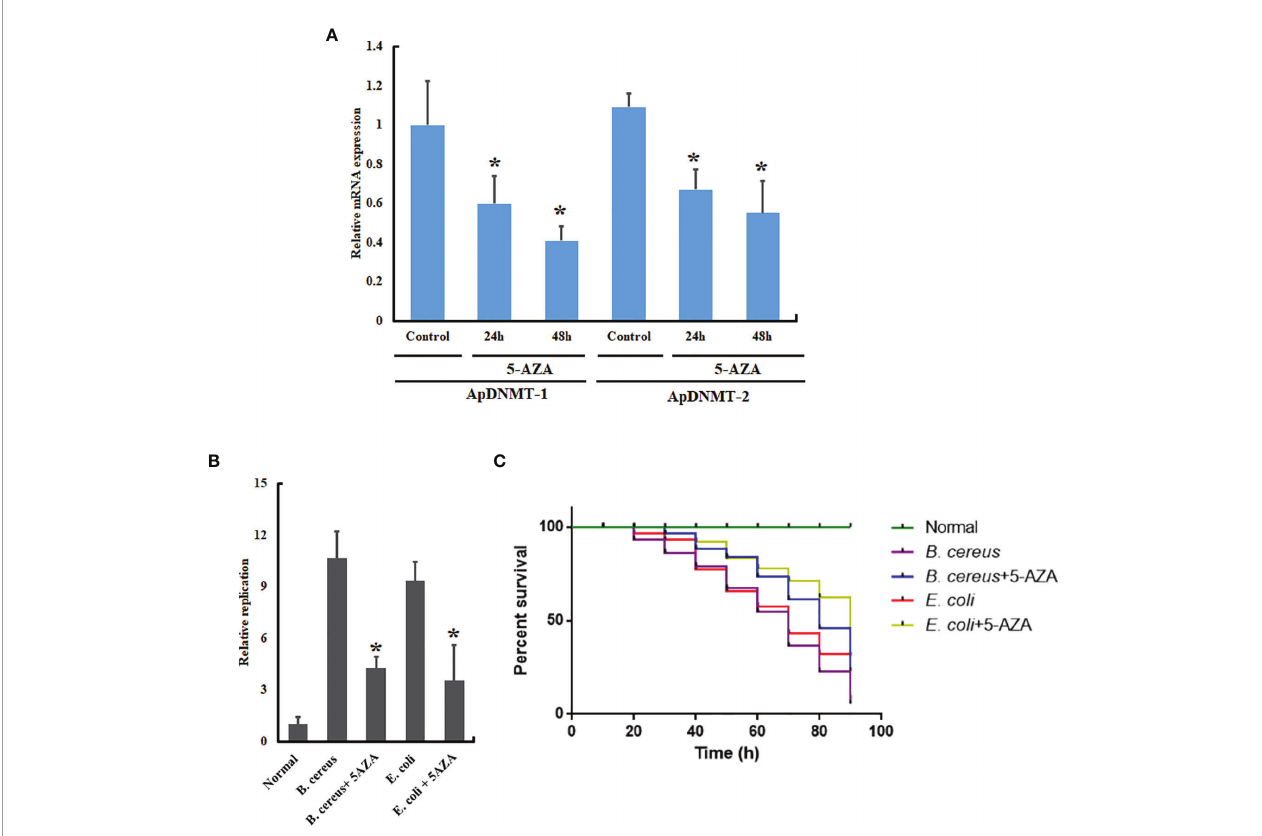
FIGURE 8 | 5-AZA administration reduced replication rates of the pathogenic bacteria and mortality rate of A . pernyi. (A) Relative mRNA expression levels of ApDNMT-1 and ApDNMT-2 in the 5-AZA-treated larvae and control group after 24 h and 48 h by qRT PCR. (B) qRT-PCR replication rate analysis showed that treatment of A . pernyi larvae with 5-AZA reduced replication rates of B . cereus and E. coli in A . pernyi . (C) 5-AZA application also decreased the mortality rate of A. pernyi following infection with the pathogenic bacteria. Bacterial DNA was quanti fi ed with universal 16S rRNA primers, and insect 18S rRNA was used as the reference control. Bars show mean ± S.E. (n = 3), and asterisks indicate signi fi cant differences (* p <